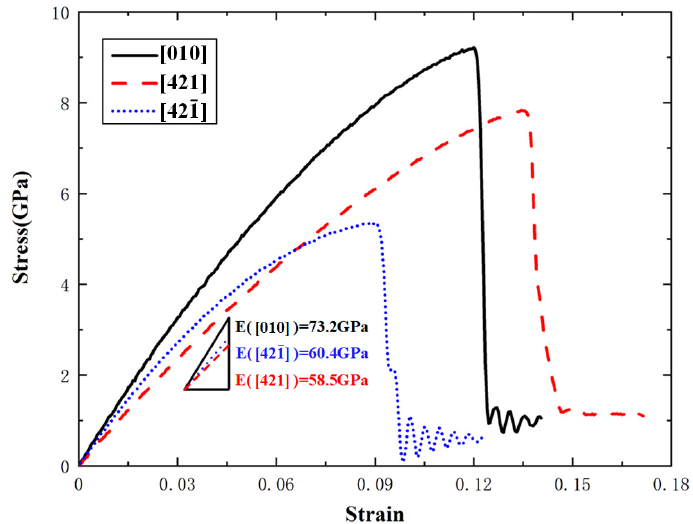
Figure 3. Uniaxial tensile stress–strain curves of single-crystal calcite along the [ 010 ] , [ 421 ] , and [ 421 ] directions at 300 K.